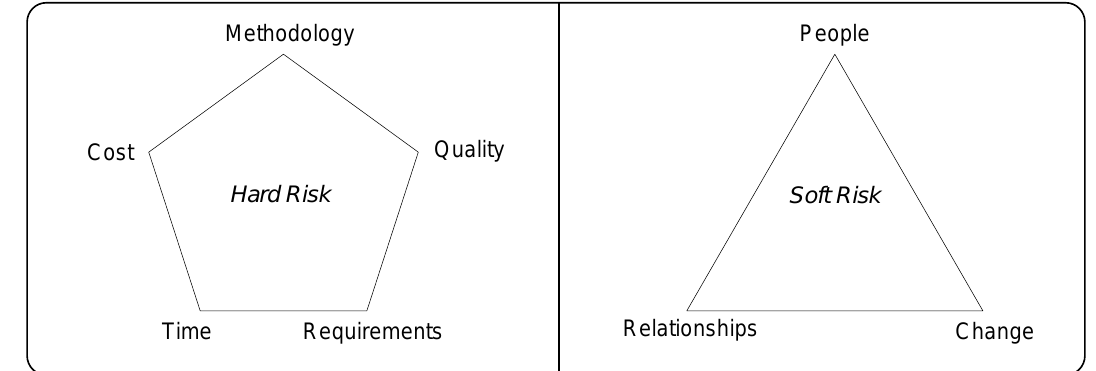
Figure 6: Hard (mechanical) and soft (dynamic) risk classification